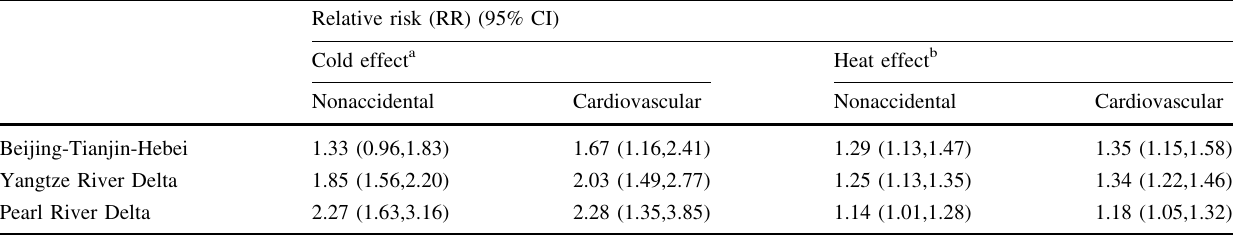
Numbers in parentheses indicate mortality risk at 95% confidence interval a Mortality risk at the 1st percentile of temperature relative to that at the MMT, with the 0–21 days’ lag b Mortality risk at the 99th percentile of temperature relative to that at the MMT, with the 0–3 days’ lag